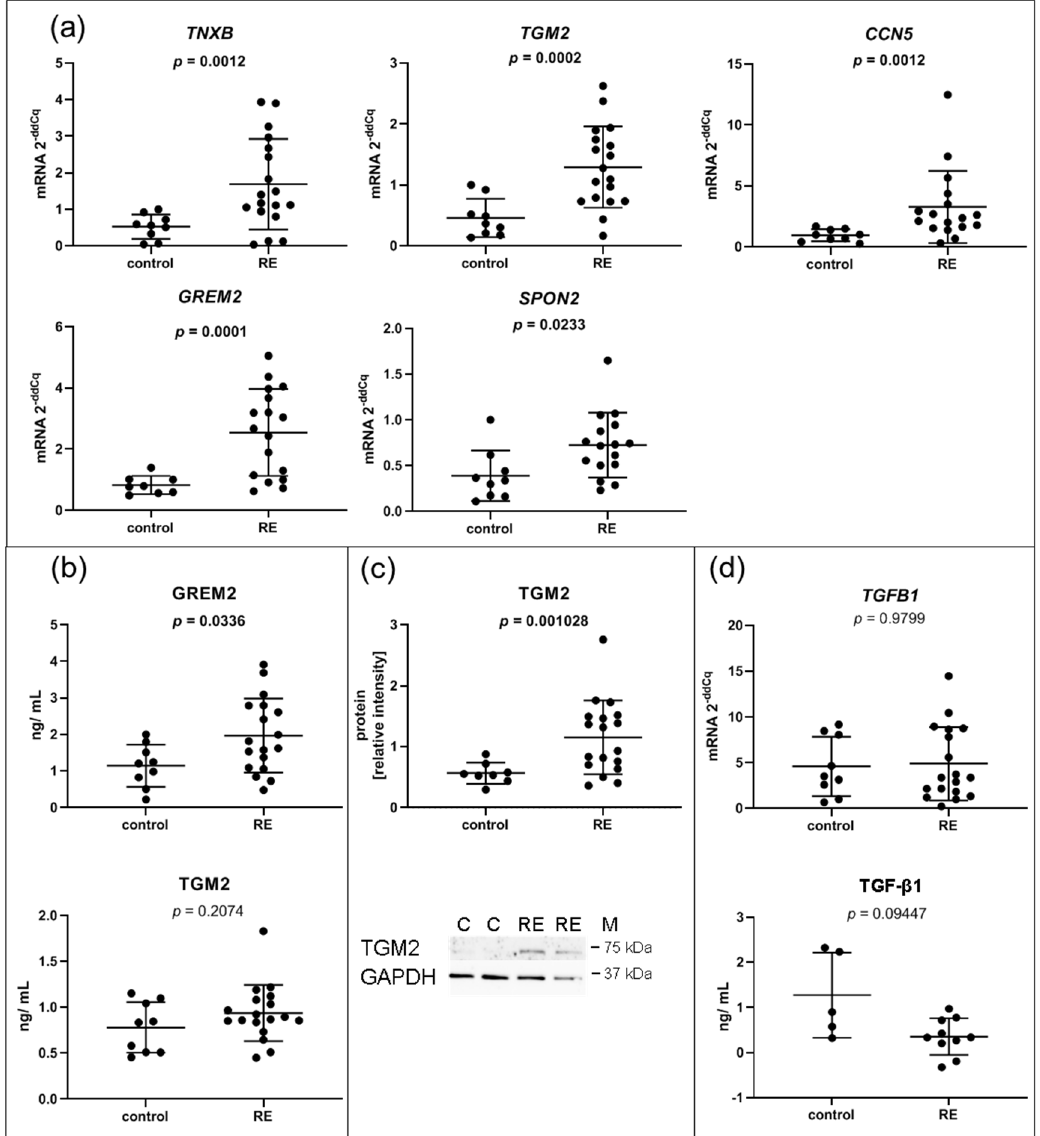
Figure 3. ECM related I: VFF from RE patients have increased expression levels of genes encoding for proteins related to the ECM and TGF- β family signaling. ( a ) Selected RNA-seq/DESeq2 differentially upregulated mRNAs compared to control samples were confirmed by qPCR, and ( b ) corresponding protein was measured in addition in the supernatant by Luminex and ( c ) in cell lysates by Western blotting; ( d ) TGFB1 gene expression was measured by qPCR and total TGF- β 1 protein in the supernatant was analyzed by ELISA. Graphs show mean ± SD of 8 to 18 samples per group (control: n = 8–9, RE: n = 17–18); total TGF- β 1 was measured in 5–9 samples per group (control: n = 5, RE: n = 9); groups were compared by Student‘s t-test, with Welch‘s correction if variances differed; in case of non-Gaussian distribution, Mann–Whitney rank test was conducted. p ≤ 0.05 was considered significant. C = control, RE = Reinke‘s edema, M = marker.